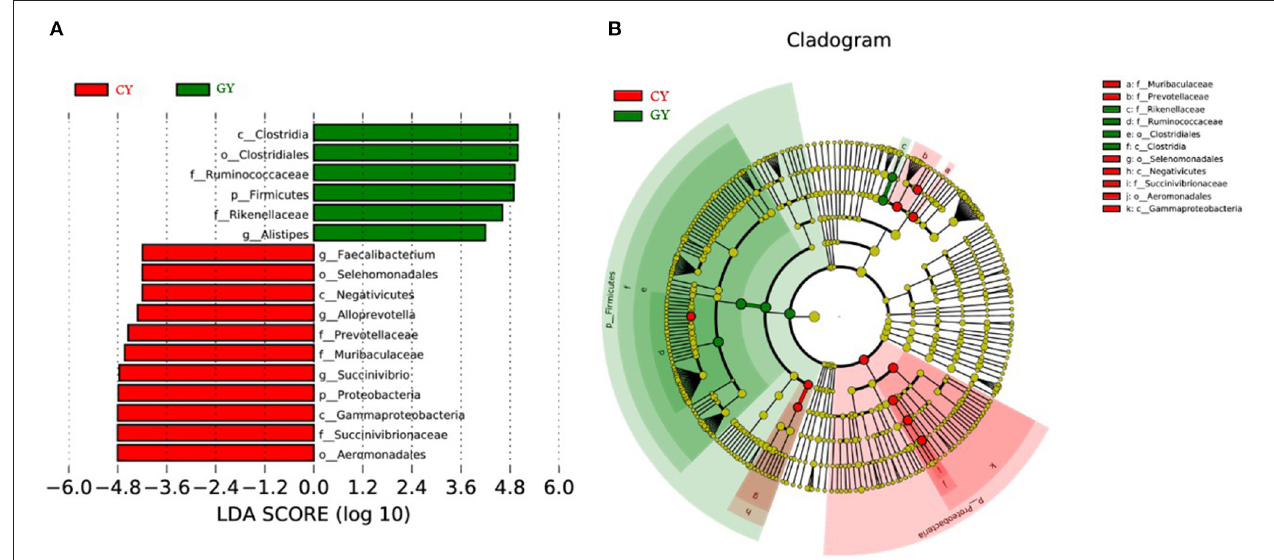
FIGURE 6 | Cladogram showing differential bacterial taxa (A) and linear discriminant analysis (LDA) effect size (LEfSe) indicating biomarker taxa (B) in yaks fed on natural grazing pasture (GY) and feedlots (FY).